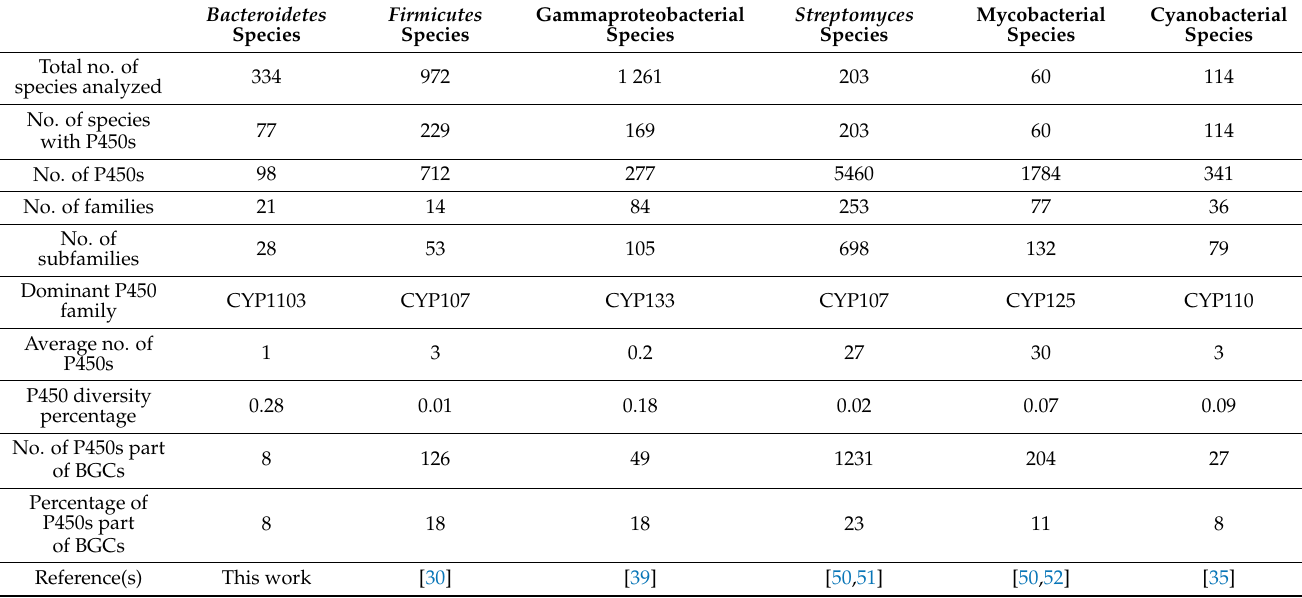
Table 2. Comparative analysis of key features of P450s and their association with secondary metabolism between Bacteroidetes species and different bacterial species. Abbreviations: No.: number, BGCs: biosynthetic gene